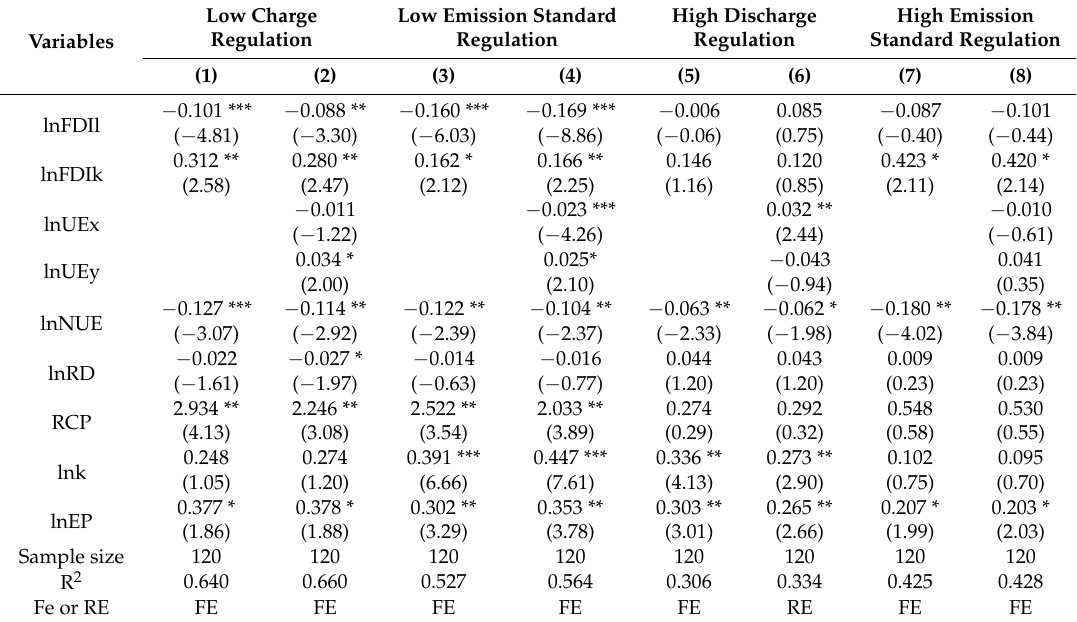
Table 2. Panel Model Regression